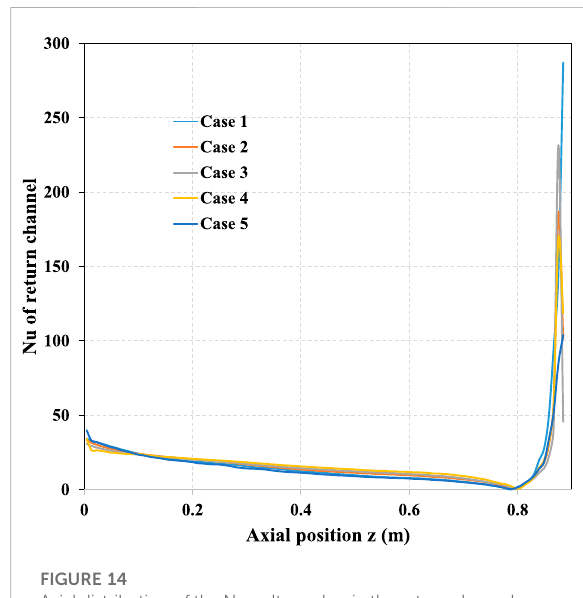
FIGURE 13 Axial distribution of the Nusselt number in fuel channel considering different Reynolds numbers and heat power.